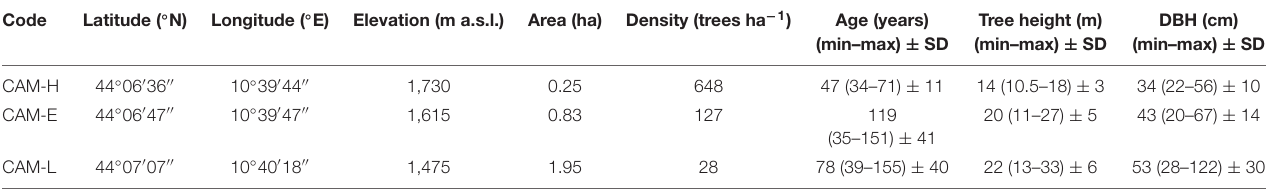
TABLE 1 | Geographic coordinates and stand characteristics of the three Norway spruce [ Picea abies (L.) H. Karst.]